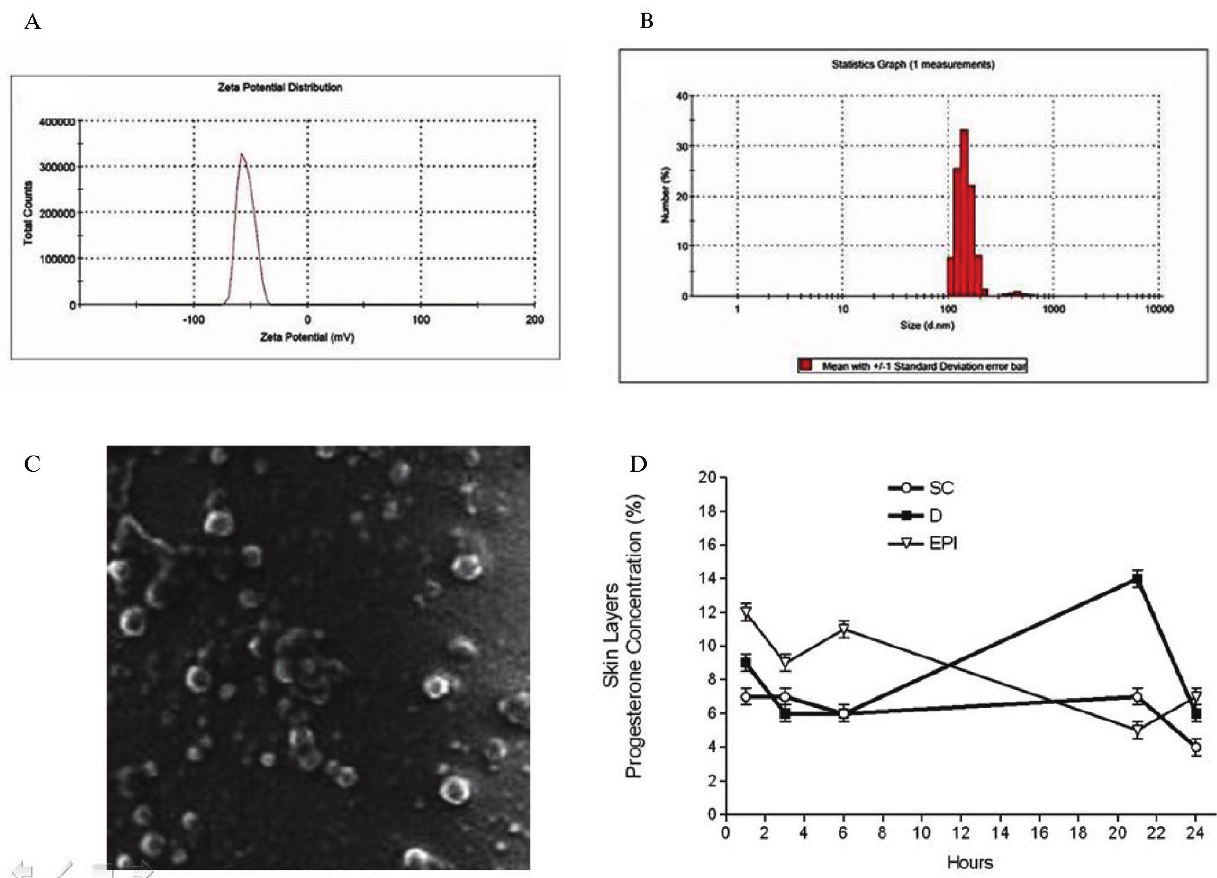
Figure 4 - A. Zeta potential analysis on Progesterone (10%) formulation administered topically in 66 postmenopausal women submitted to THRT during 60 months. Zetasizer Nano ZS90 (Malvern Instruments Ltd., UK, England). B. Zeta potential analysis